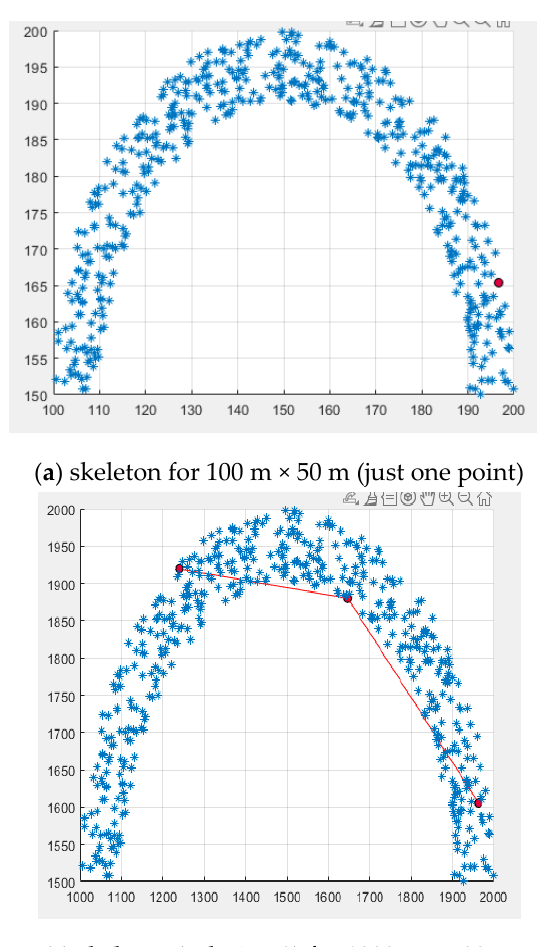
Figure 11. Detected skeletons for different cases.